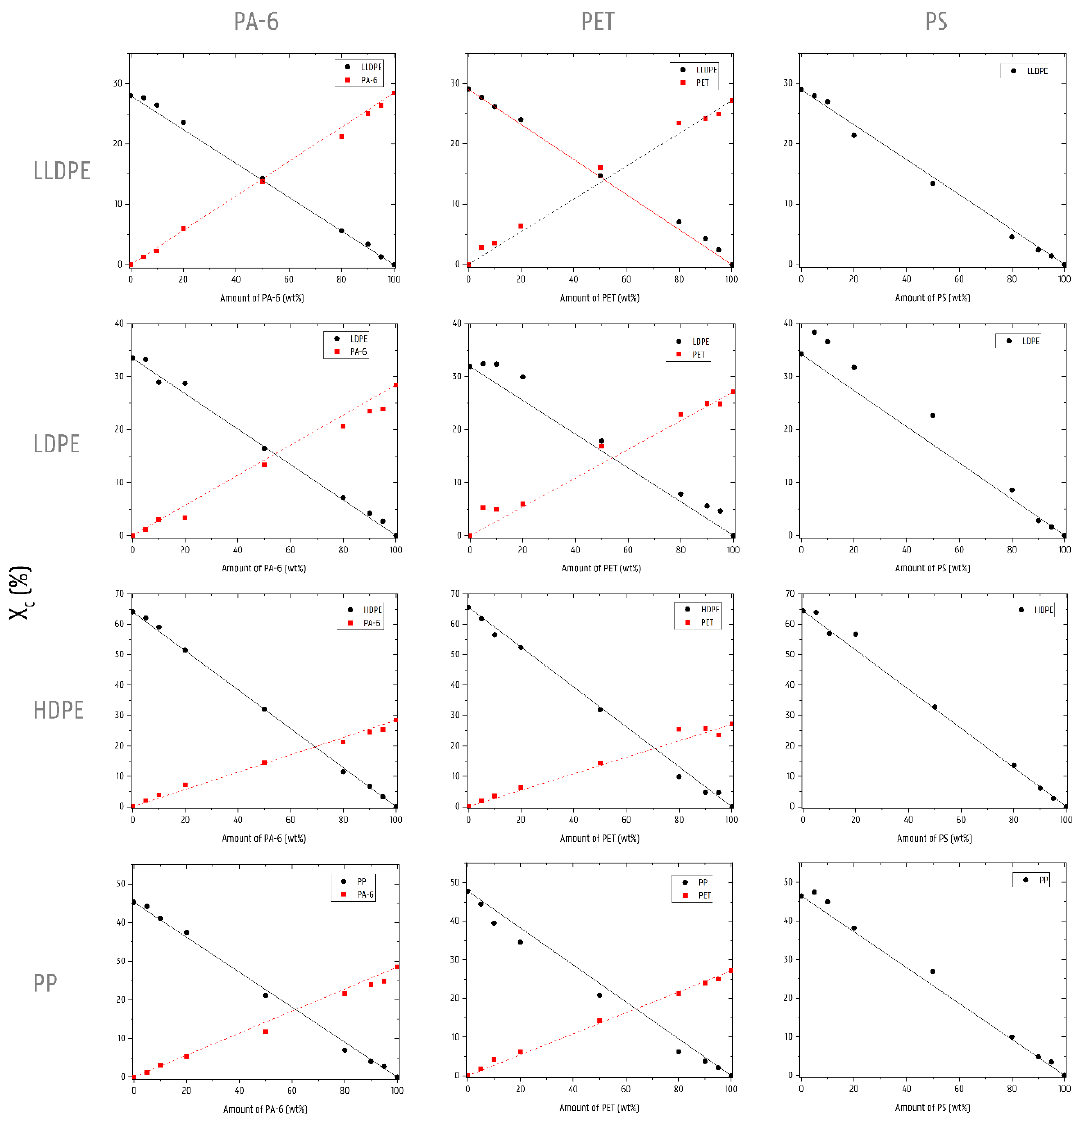
Figure 1. Crystallinity of all blend series. Experimental measured values are represented by symbols ( ● : PO materials and ■ : NPO materials). Lines are used to represent the prediction based on the additivity rule (___: prediction for PO materials and _ _ _: prediction of NPO materials).